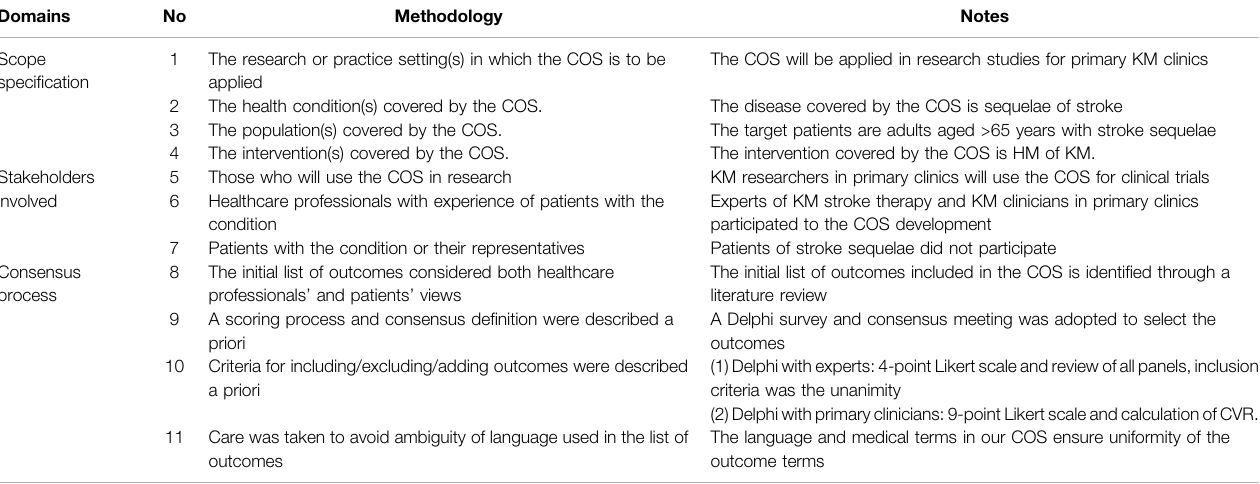
TABLE 1 | Recommendations of the Core Outcome Set Standards for Development (COS-STAD).